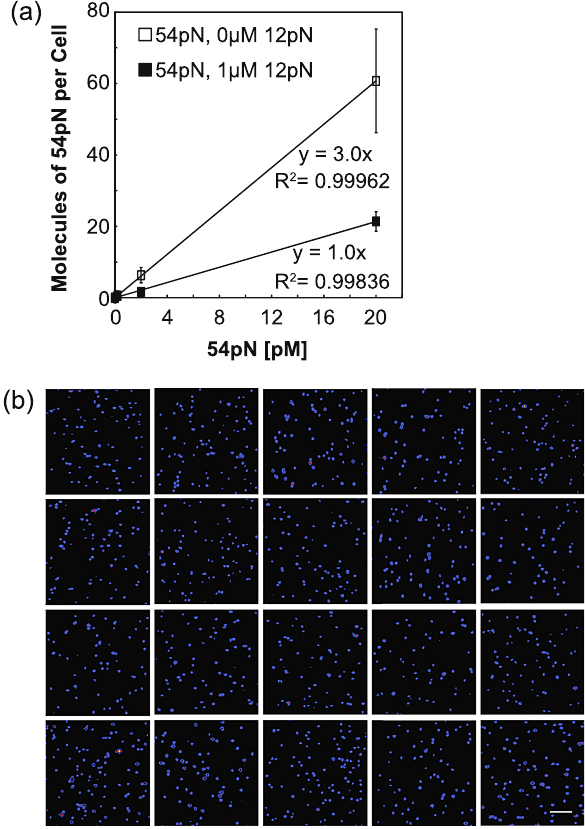
FIG. 6. Single molecule measurements of strong TGT density. (a) At picomolar incubation concentrations, the average surface densities of strong TGT in the presence of unlabeled 1 μ M of weak TGT were directly determined using single-molecule total- internal-reflection fluorescence microscopy. From these mea- surements, the number of strong TGT per cell as a function of the pM incubation concentrations was estimated. Note that the surface density of strong tethers is 3 times lower when they are presented together with weak tethers, probably because weak and strong tethers can compete with each other for a finite number of binding sites on the surface. (b) 20 single-molecule images of DNA tethers (50 pM Cy5-labeled strong TGTs and 1 μ M unlabeled weak TGTs during incubation) show that there is no nonrandom clustering of tethers. The scale bar in the lower right image is 5 μ